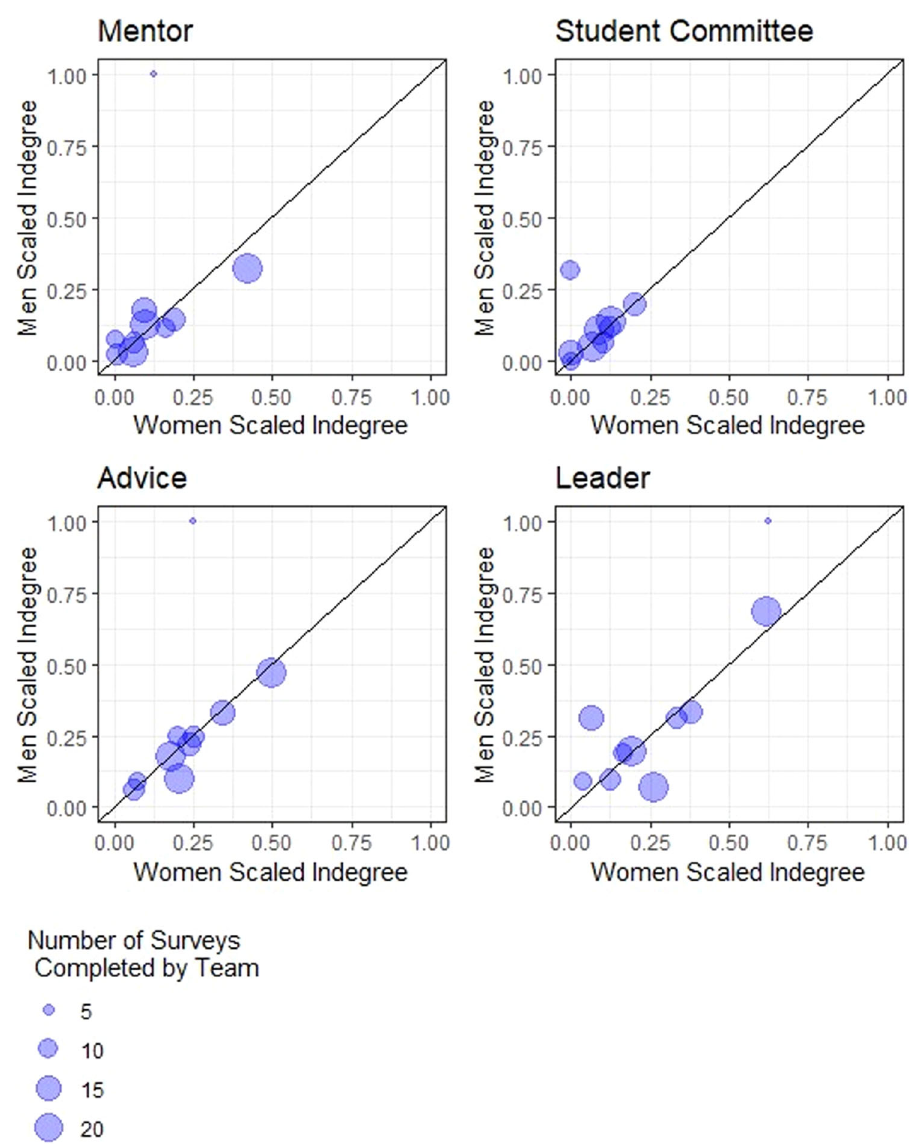
Fig. 1 For each team and each social network, the average scaled indegree was computed for the women and the men team members. These are plotted against one another, where the size of the dot re fl ects the number of team members that completed the survey. When the number of respondents is low (a small dot), the scaled indegree is expected to be more variable, whereas when the number of respondents is high (a large dot), the scaled indegree is expected to be less variable and more representative of the whole team ’ s perceptions. Each graph reports a different social network question (mentor, student committee, advice, and leader).